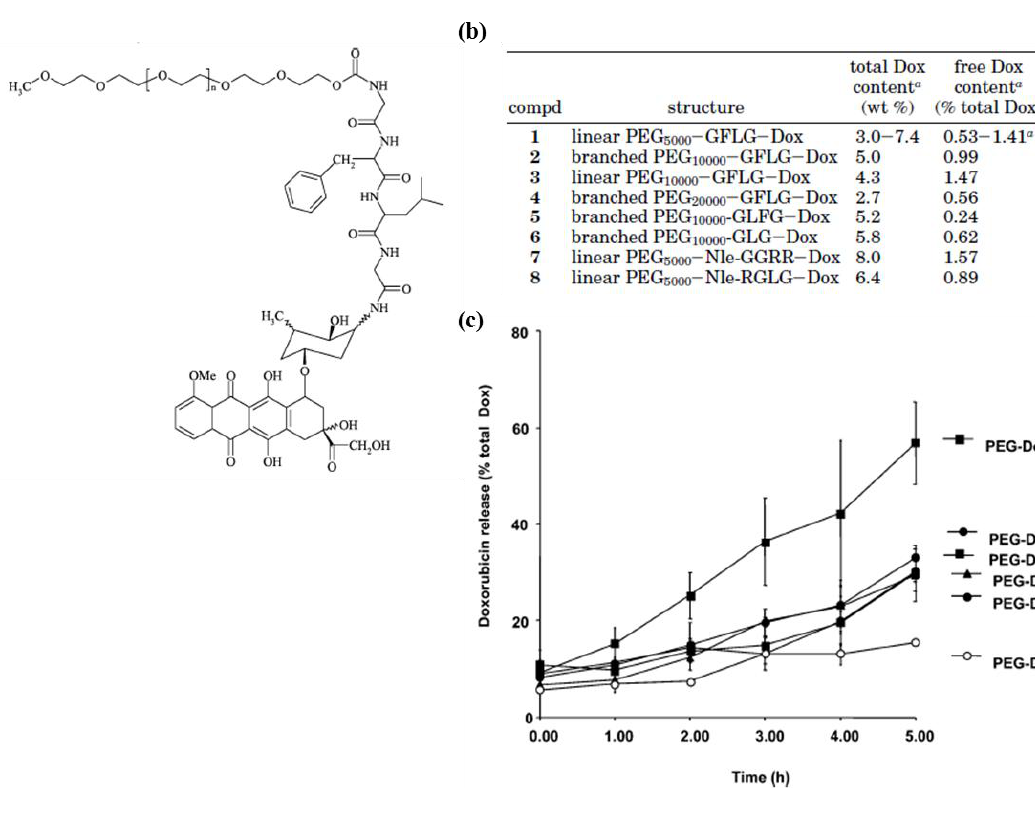
1. ( a ) Structure and ( b ) composition of the poly(ethylene glycol) (PEG)-peptide-doxorubicin (DOX) conjugates. Release of DOX from PEG-peptide-DOX conjugates during incubation with isolated rat liver lysosomal enzymes (tritosomes). Reproduced from [9] with permission of [American Chemical Society